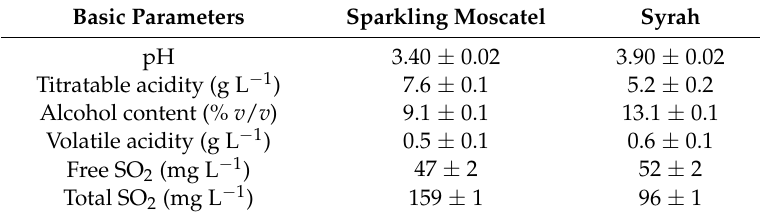
Table 1. Basic parameters (mean ± standard deviation) of the sparkling Moscatel and Syrah